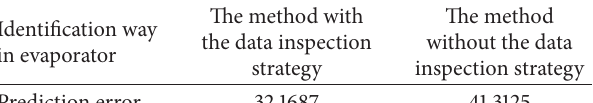
Table 4: The prediction errors with and without the data inspection strategy in the evaporator example.